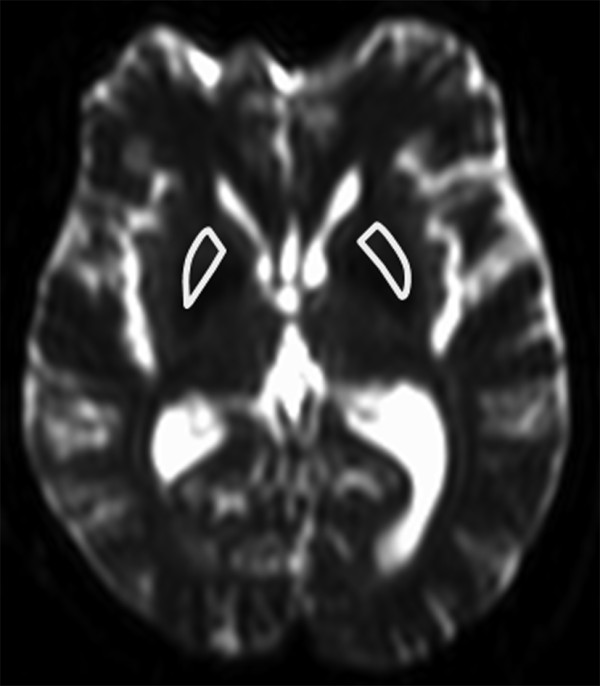
Examples of regions-of-interest (ROIs) used in the measurement of MD values of the putamen. The ROIs were drawn manually on the echo-planar images with no diffusion weighting, and superimposed onto the MD maps. ROIs drawn on an echo-planar image with no diffusion weighting are shown.